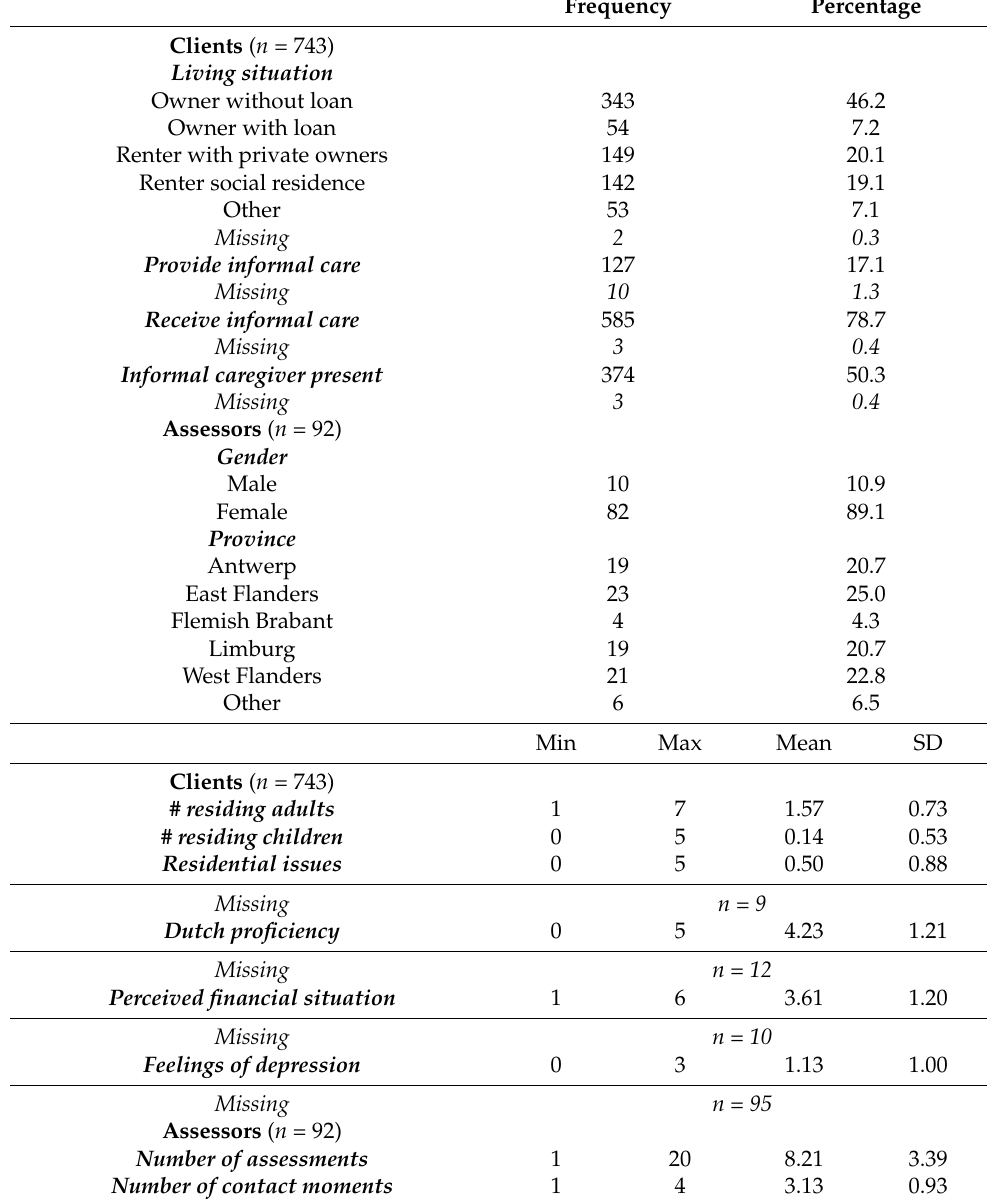
Table 1. Descriptive overview of client ( n = 743) and assessor ( n = 92)